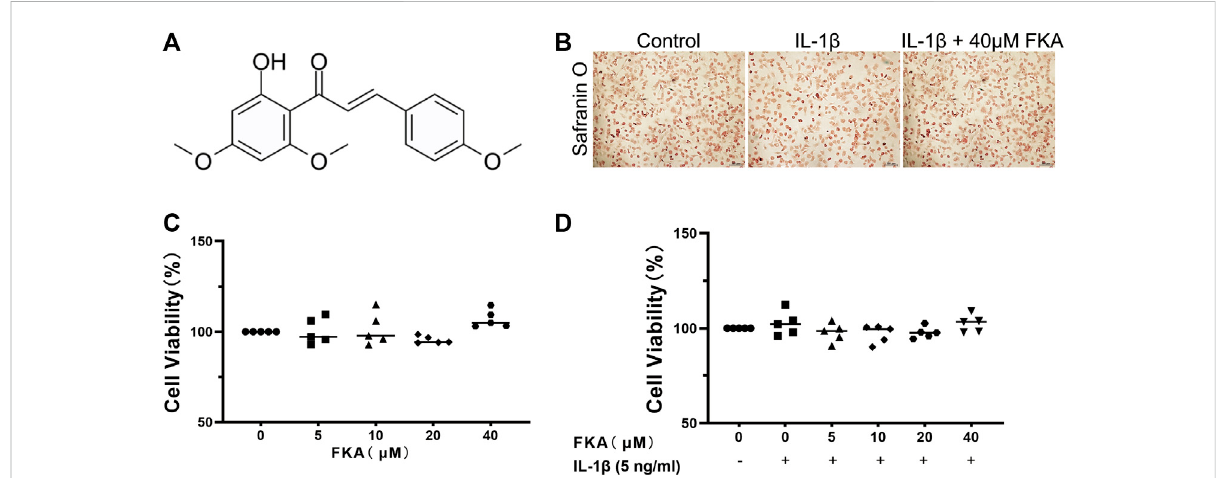
FIGURE 1 Effects of FKA on chondrocyte viability (A) Chemical Structure of FKA. (B) Safranin O staining of chondrocyte cells after treatment with IL-1 β (5 ng/ml) and FKA for a period of 24 h (scale bar 100 μ m). Viability of chondrocyte cells after 24 h intervention with various concentrations of FKA in the absence (C) or presence of IL-1 β (D) tested using the CCK8 kit. The values are presented as means ± SD ( n =